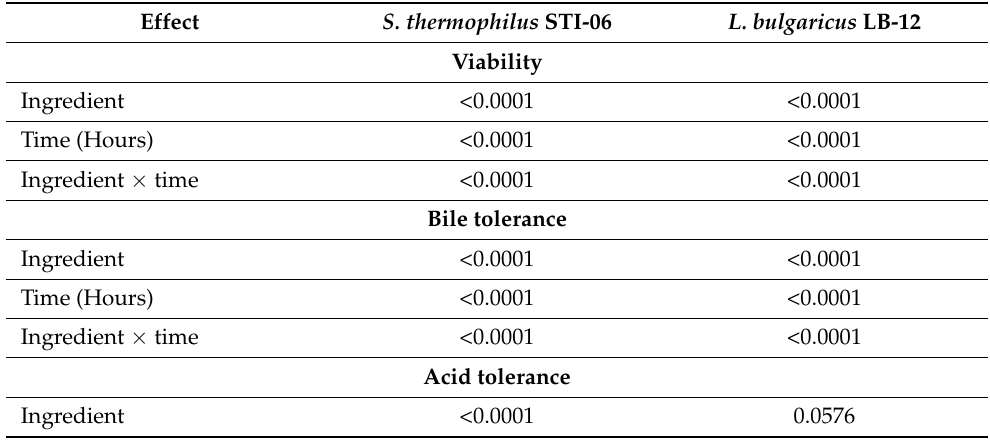
Figure 2. Log counts of Lactobacillus bulgaricus showing its acid tolerance as in fl uenced by di ff erent ingredients over an incubation period of 120 min. C = control, LG = L-glutamine (7 g/L), Q = quercetin (700 mg/L), SEB = slippery elm bark (210 mg/L), MR = marshmallow root (1340 mg/L), NAG = N-acetyl-D-glucosamine (210 mg/L), LR = licorice root (210 mg/L), MM = maitake mushrooms (42 mg/L), and ZN = zinc orotate (70 mg/L). Error bars represent SE. Many reports have revealed varying e ff ects concerning the e ff ect of polyphenols and herbs on the growth of probiotics. Licorice root may contain mucilaginous materials that can coat probiotics and reduce gastric acidity, improve gastric emptying, and promote gastric healing [32]. Similarly, the main active compounds from Althaeae sp. root are polysaccharides that contain high quantities of starch (37%), mucilages (15–35%), and pectins (10–12%) [33]. These components can be coating agents that can protect the probiotics. On the other hand, anti-microbial activity of medicinal plants may be due to